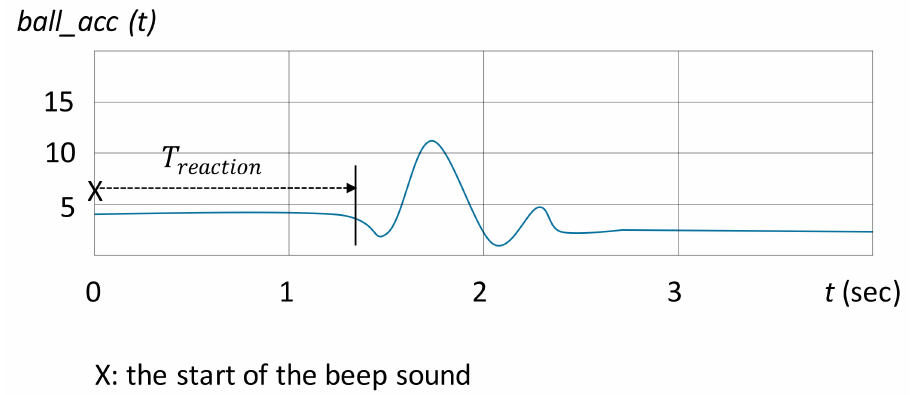
Figure 4. Illustration of the signal from ball_acc . The reaction time ( T reaction ) was defined as the interval from the beep sound (denoteds as “x”) to the time at which the ball started